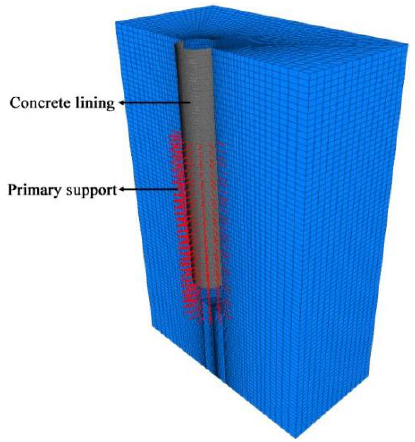
Figure 11. Calculation model of shaft excavation and support.